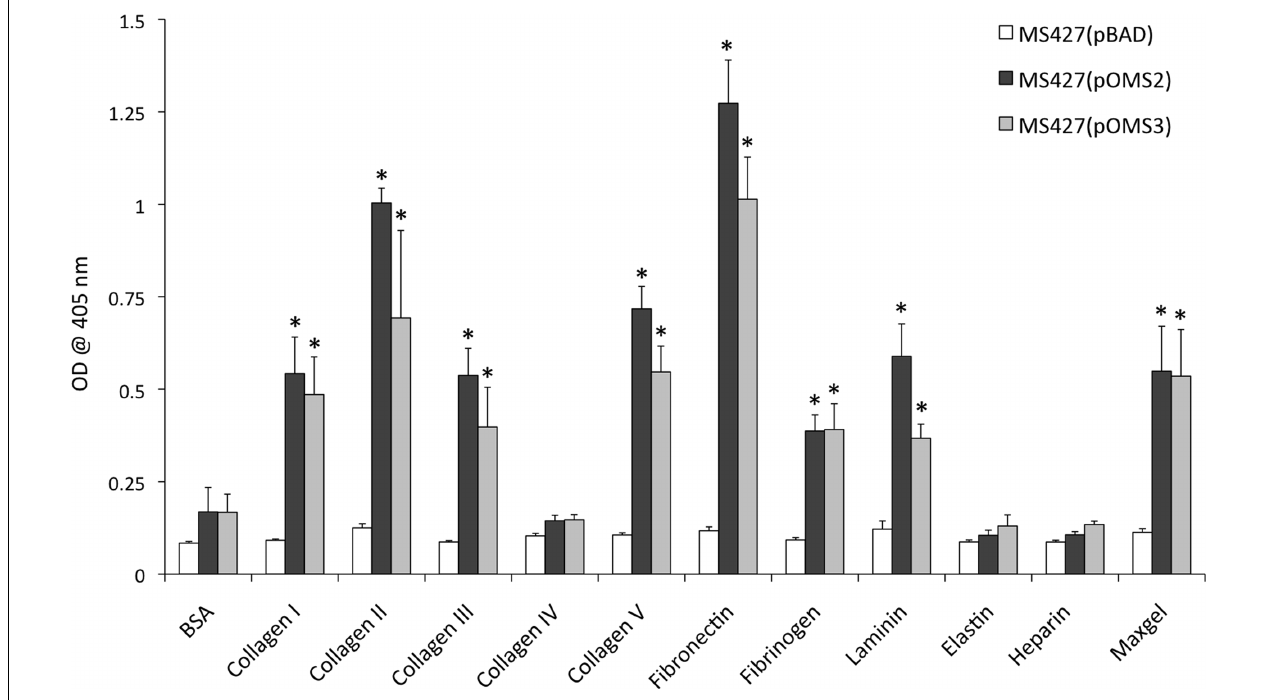
FIGURE 4 | EhaJ mediates attachment to a range of ECM proteins in an ELISA-based binding assay. MS427 bound to MaxGel, collagen I, II, III andV, fibronectin, fibrinogen, and laminin when expressing ehaJ with or without